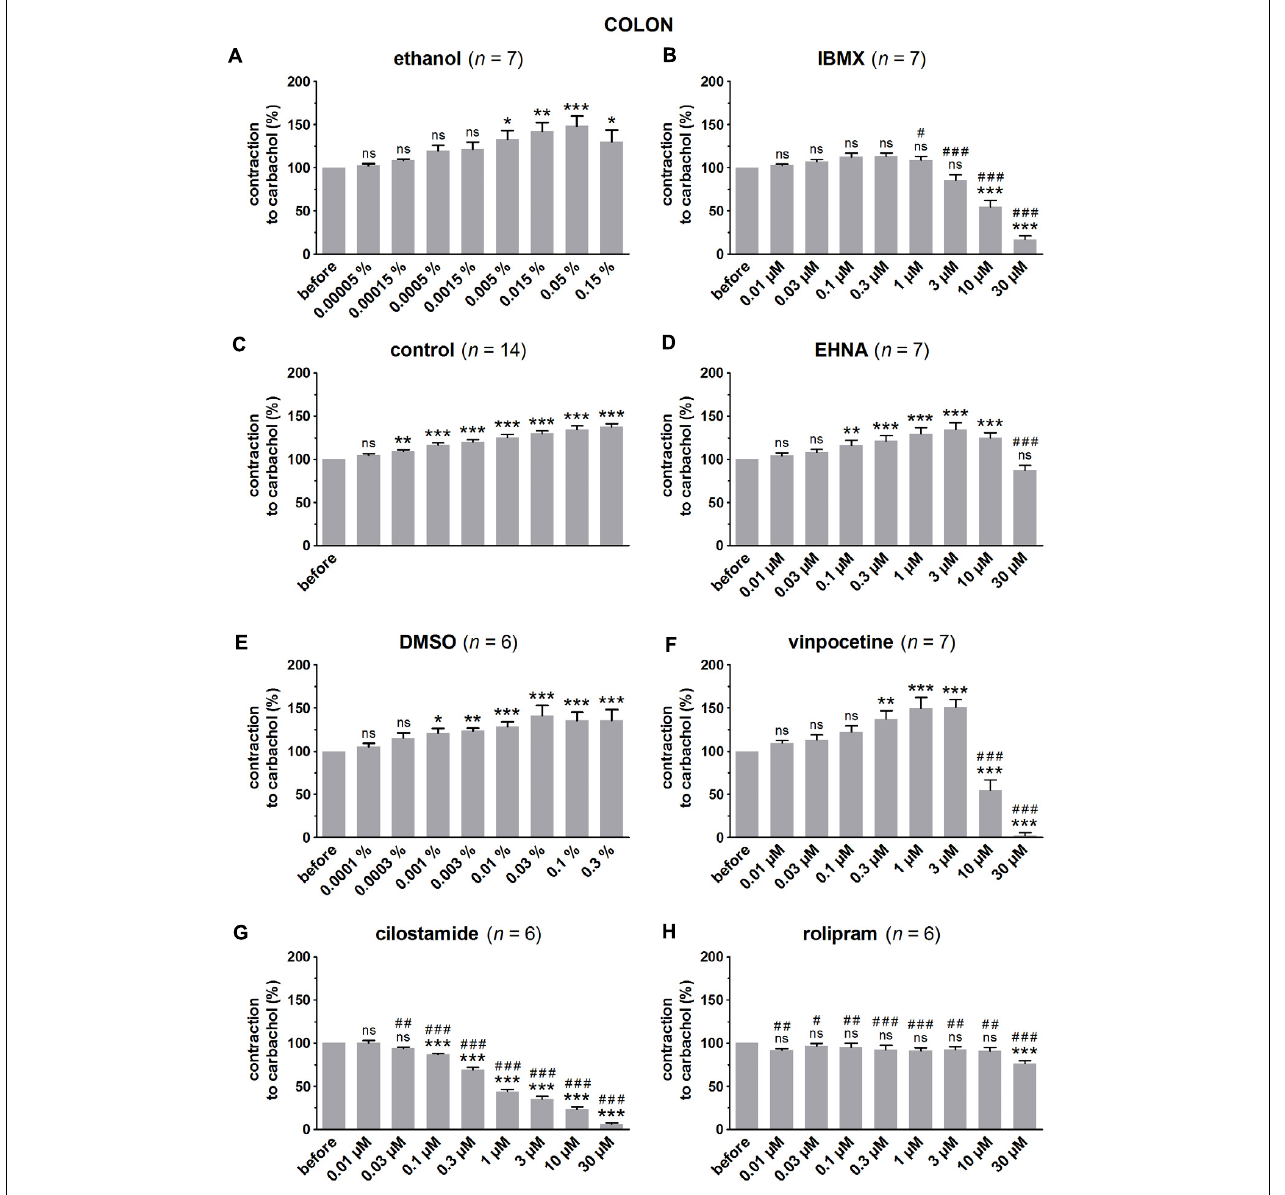
FIGURE 3 | Influence of increasing concentrations (0.01–30 µ M) of the PDE inhibitors IBMX (B) , EHNA (D) , vinpocetine (F) , cilostamide (G) and rolipram (H) , and the solvents ethanol (A) and DMSO (E) on submaximal carbachol-induced contractions (0.3 µ M) in murine colon circular smooth muscle strips. Parallel time controls not receiving PDE inhibitor or solvent are shown in (C) . Contractions in the presence of increasing concentrations of the PDE inhibitor are expressed as percentage of the reference contraction before addition of the PDE inhibitor. Means ± SEM; ns not significant, ∗ P < 0.05, ∗∗ P < 0.01, ∗∗∗ P < 0.001 versus reference before (repeated measures ANOVA with Bonferroni corrected t -test) and # P < 0.05, ## P < 0.01, ### P < 0.001 versus corresponding control (unpaired t